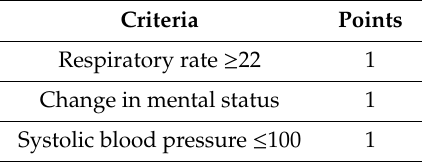
Table 1. qSOFA (quick Sepsis Related Organ Failure